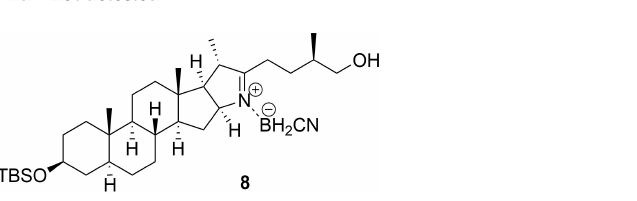
Figure 2. Complex 8 formed during the imine 3 reduction with NaBH 3 CN/AcOH.